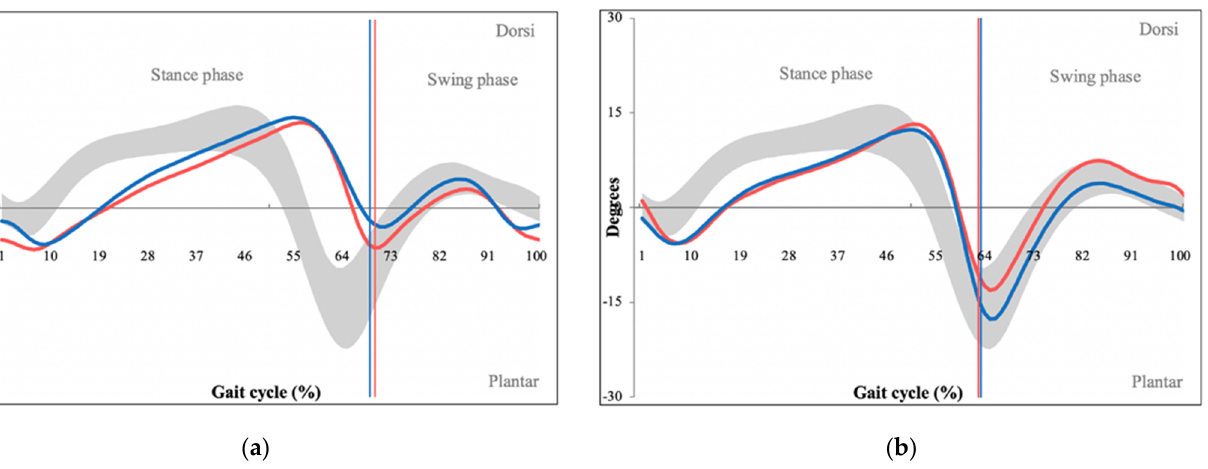
Figure 8. Kinematic graphs of ankle plantar and dorsal flexion of a patient with LSS ( a ) and their matched control ( b ), demonstrating limited ankle plantar and dorsal flexion. Degrees of movement are shown on the vertical axis whereas the horizontal axis portrays gait cycle. (Red line—left leg values, blue line—right leg values, grey space—normative values of ankle plantar/dorsal flexion.) Kinematic parameters of the knee joints did not demonstrate significant differences between the patient and control group (PG = 8.46, CG = 9.74, p = 0.192) (Figure 9).